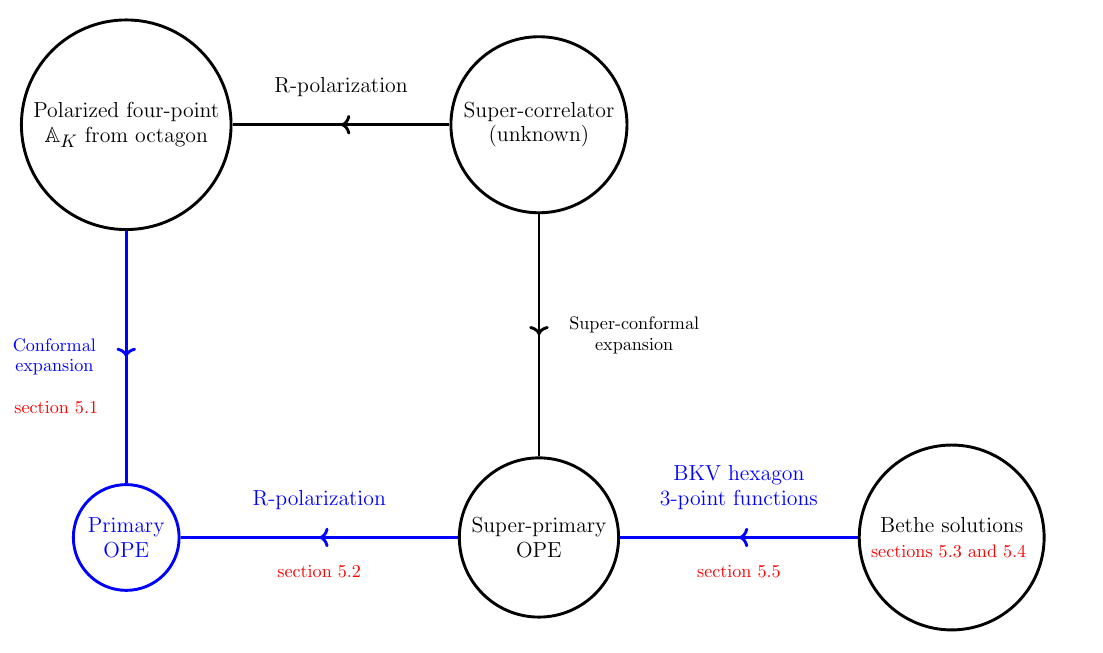
Figure 10 . OPE strategy to test octagon at nine